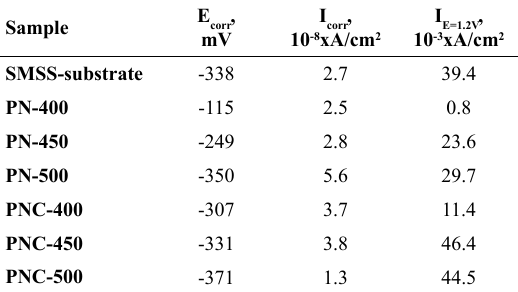
Table 2. Electrochemical parameters from the polarization curves of the plasma nitrided and nitrocarburised SMSS samples.